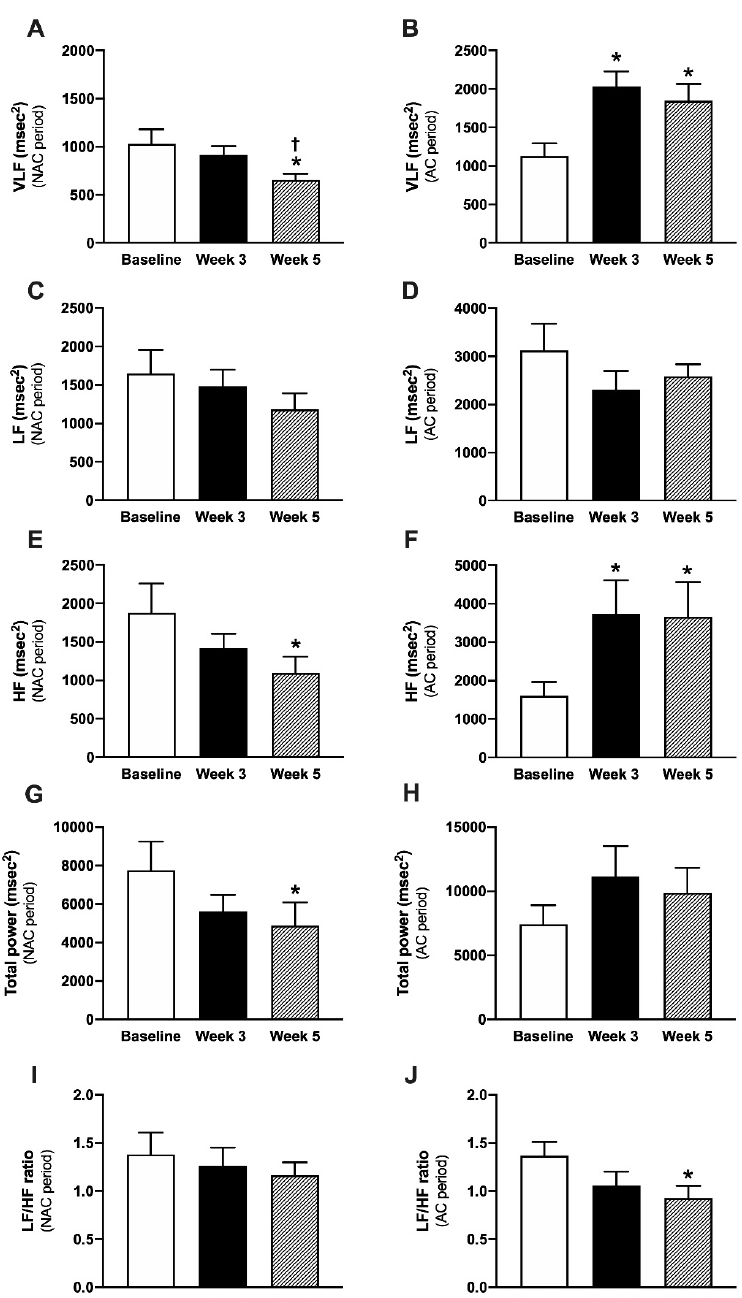
Figure 2. Frequency domain parameters in the NAC ( A , C , E , G , I ) and the AC ( B , D , F , H , J ) periods. Abbreviations: NAC period = no acupuncture treatment period, AC period = acupuncture treatment